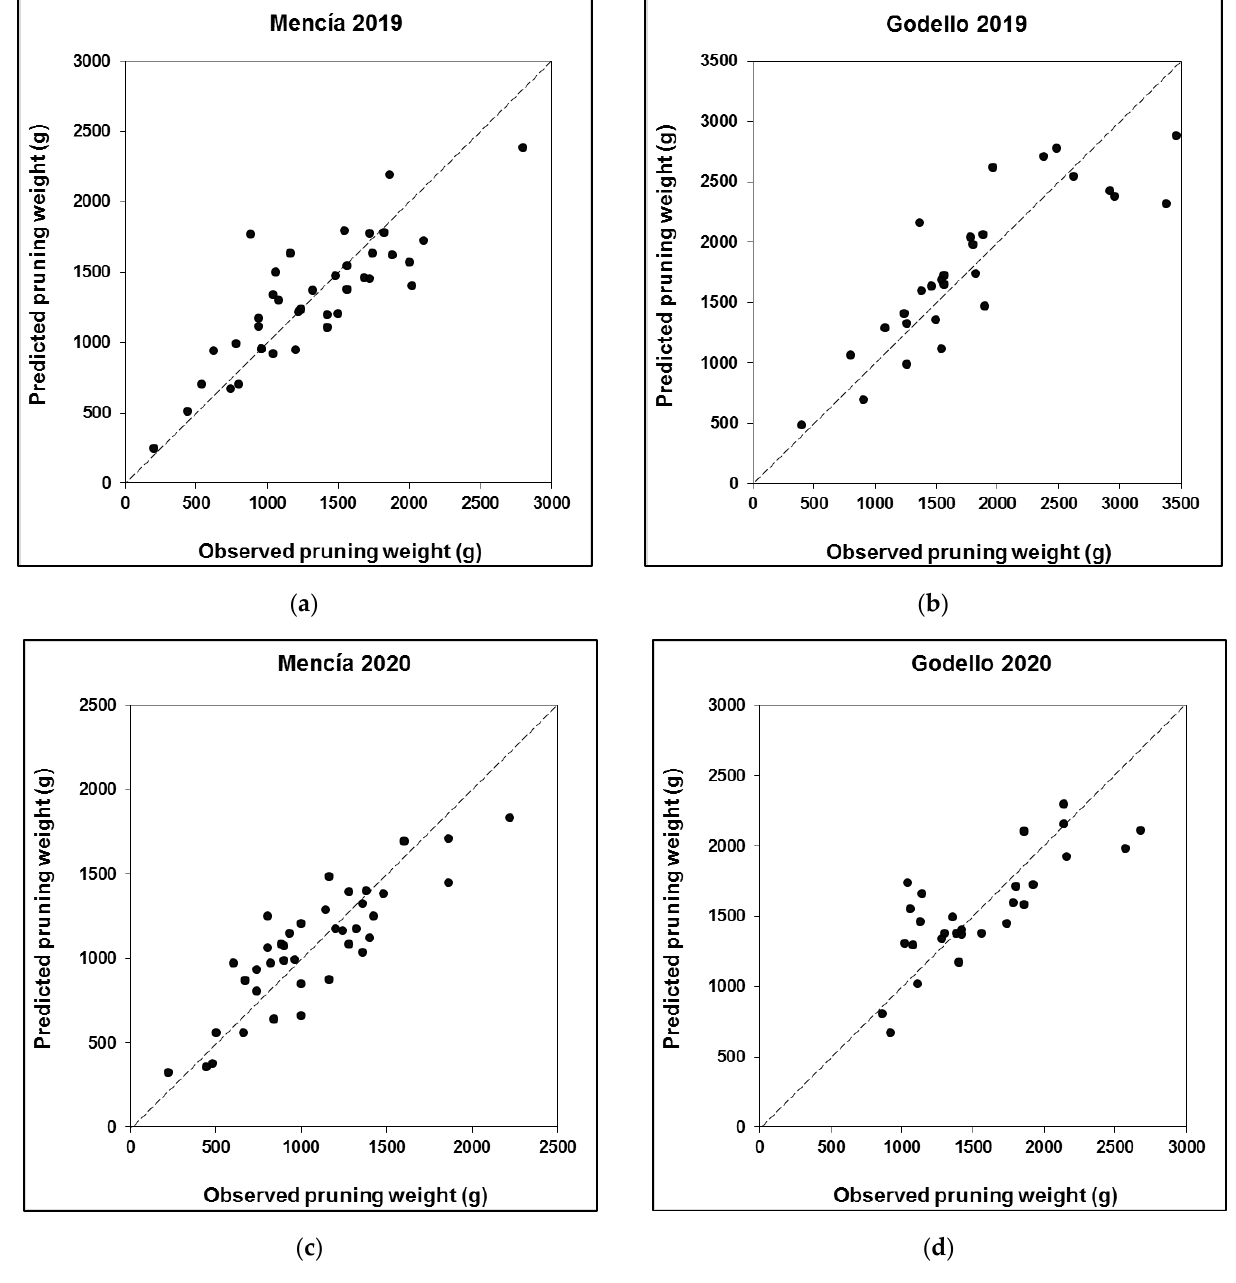
Figure 3. Predicted vs. observed pruning weight validated with the leave-one-out cross procedure for: ( a ) Mencía 2019; ( b ) Godello 2019; ( c ) Mencía 2020; ( d ) Godello 2020 (dashed lines = 1:1)